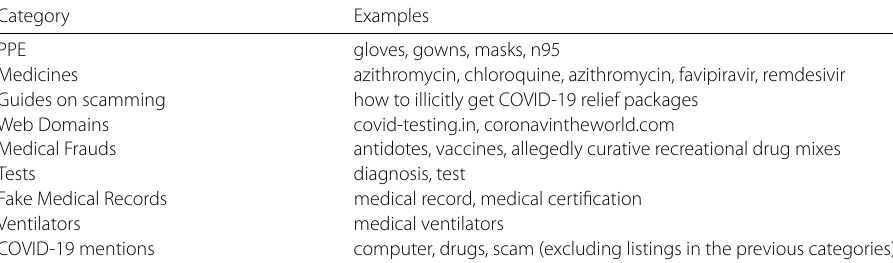
Table 1 Categories used to classify the selected COVID-19 dataset. The first five categories constitute COVID-19 specific listings, while the last one, called COVID-19 mentions , includes listings mentioning one of the keywords in Table 5 without selling actual COVID-19 specific listings